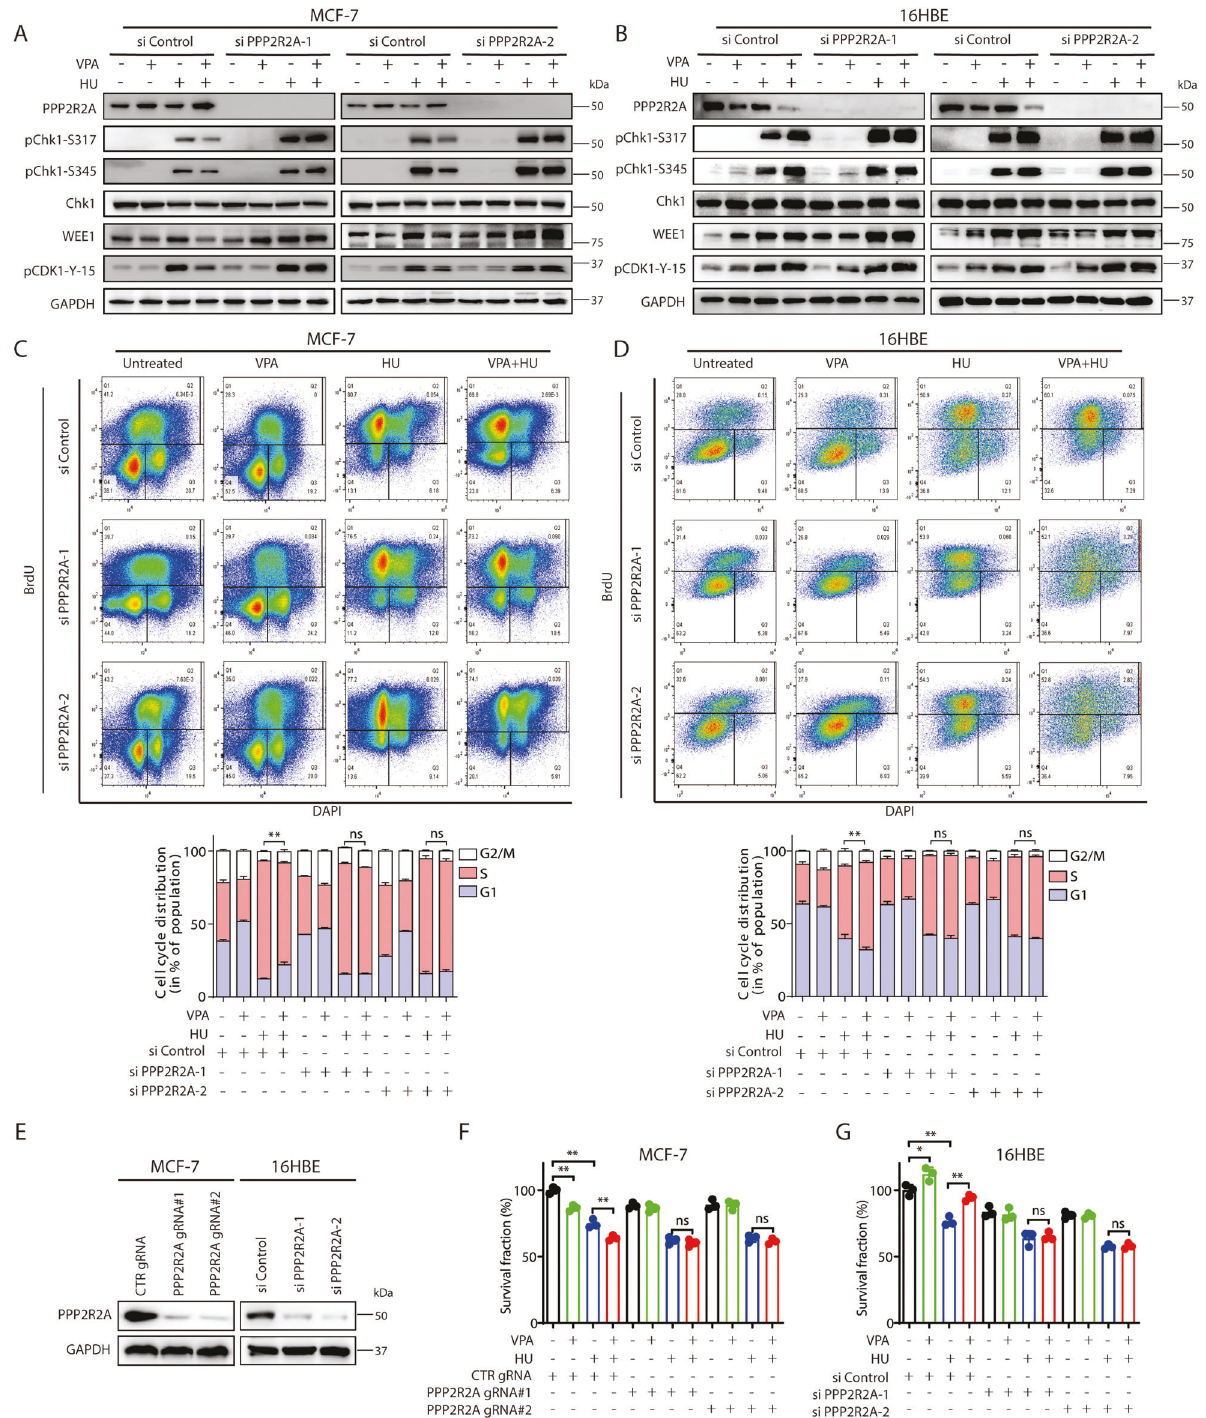
Fig. 3 PPP2R2A regulates the cell survival of cancer and normal cells through Chk1-associated pathway in response to HU treatment. A , B MCF-7 and 16HBE cells were transiently transfected with indicated PPP2R2A-targetiing siRNAs (siPPP2R2A-1 and siPPP2R2A-2). After 24 h, cells were treated with 0.5 mM VPA and/or 2 mM HU. The protein levels of PPP2R2A, pChk1-S317, pChk1-S345, Chk1, WEE1 and pCDK1-Y-15 were analyzed by Western blotting. GAPDH was used as loading control. C , D MCF-7 and 16HBE cells were treated as stated in A and B . Cell cycle analysis of the DNA content of MCF-7 and 16HBE cells were performed by fl ow cytometry. Cell cycle analysis is shown as mean ± SD ( n = 3). Statistical signi fi cance is displayed for S cells. ** P < 0.01; ns, not signi fi cant. E – G MCF-7 cells were transduced with non-targeting gRNA (CTR gRNA) or PPP2R2A-targeting gRNAs (PPP2R2A gRNA#1 and PPP2R2A gRNA#2), and 16HBE cells were transiently transfected with indicated siPPP2R2A (siPPP2R2A-1 and siPPP2R2A-2). Western blotting was performed to evaluate PPP2R2A expression ( E ). Cell survival in either MCF-7 cells ( F ) or 16HBE cells ( G ) treated by 0.5 mM VPA or/and 2 mM HU was detected by CCK8 assay. Each data point in the graph was from three independent experiments, * P < 0.05, ** P < 0.01; ns not signi fi cant. Cell Death and Disease (2023)